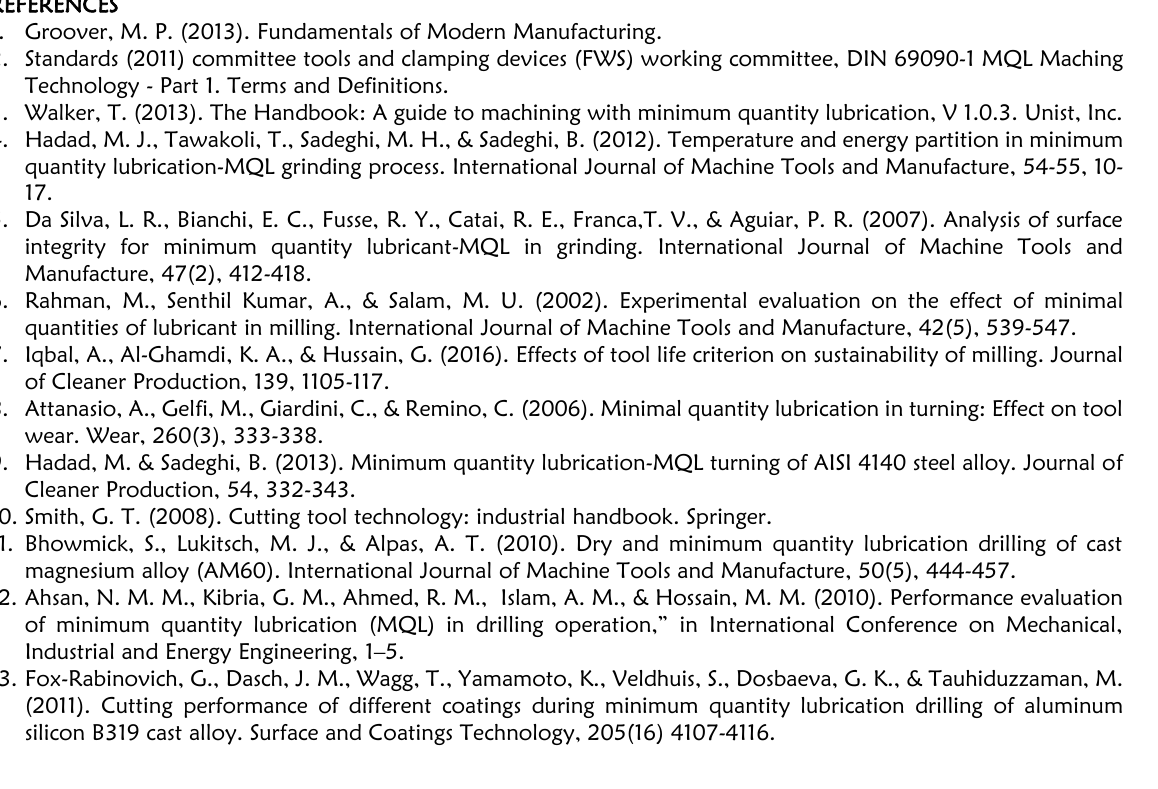
Figure 3: Interaction graph between experiment conditions and tool materials on the tool wear [X= A: Tool Material, Y=B: Type of